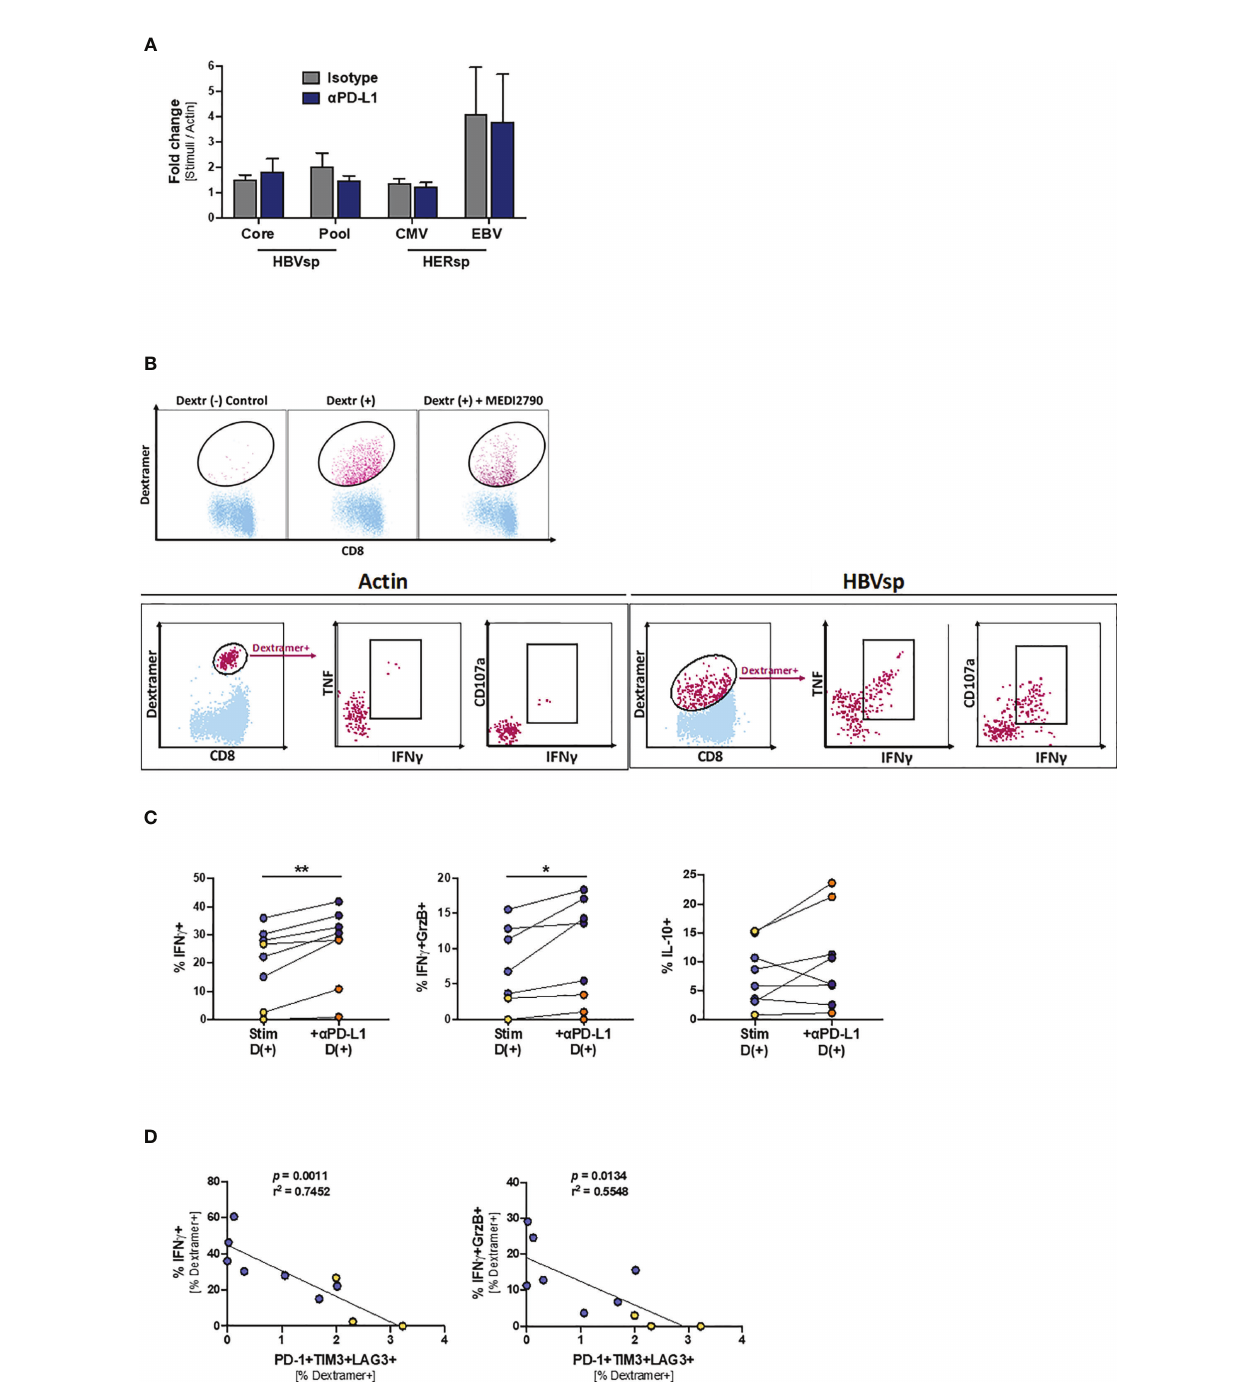
FIGURE 6 | PD-L1 blockade increases the frequency of IFN g -producing Ag-speci fi c CD8 T cells. (A) Effect of PD-L1 blockade on the proliferation levels of Ag- speci fi c CD8 T cells. (B) Representative fl ow plots showing the gating strategy for intracellular cytokine staining of dasatinib-treated HBV-speci fi c CD8 T cells. Dextramer-positive CD8 T cells (maroon) are overlaid on bulk CD8 T cells (light blue). While cytokines cannot be detected on samples stimulated with Actin negative control (left panel), dasatinib-treated stimulated HBV-speci fi c T cells accumulate both cytokines and degranulation markers (right panel). (C) Effect of PD-L1 blockade in IFN g (left panel), IFN g +GrzB+ (middle panel) and IL-10 (right panel) production. Blue dots show HERPES-speci fi c stimulations (CMV or EBV) while orange dots show HBV-speci fi c stimulations (pool). *p < 0.05; **p < 0.001; Wilcoxon signed rank test. (D) Linear regression showing the negative correlation between Ag-speci fi c IFN g production and the frequency of highly exhausted (LAG3+TIM3+PD-1+) Ag-speci fi c CD8 T cells. Blue dots show HERPES-speci fi c stimulations (CMV or EBV) while orange dots show HBV-speci fi c stimulations